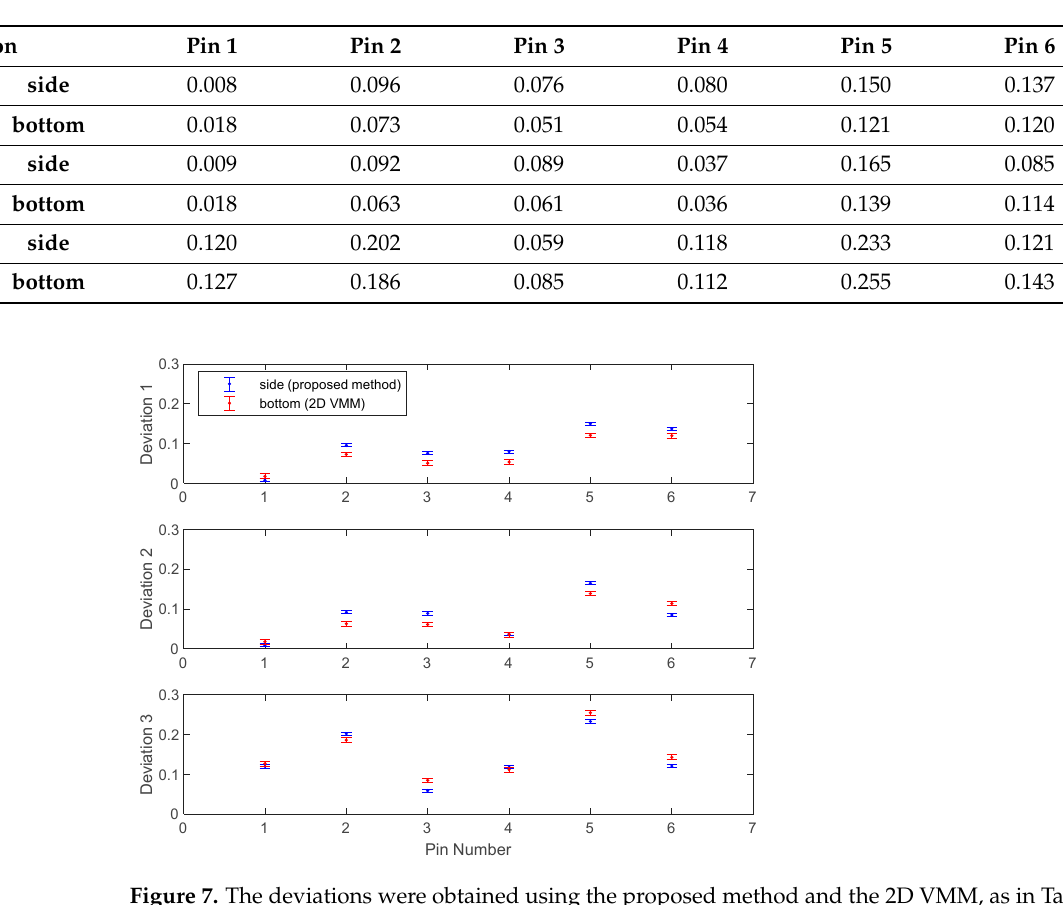
Table 1. The deviations of the first six pins of the three samples measured in case study one. “Side” means that the measurement was performed from the side of the samples using the proposed method, and “bottom” means that the measurement was performed from the bottom of the samples using the 2D VMM.